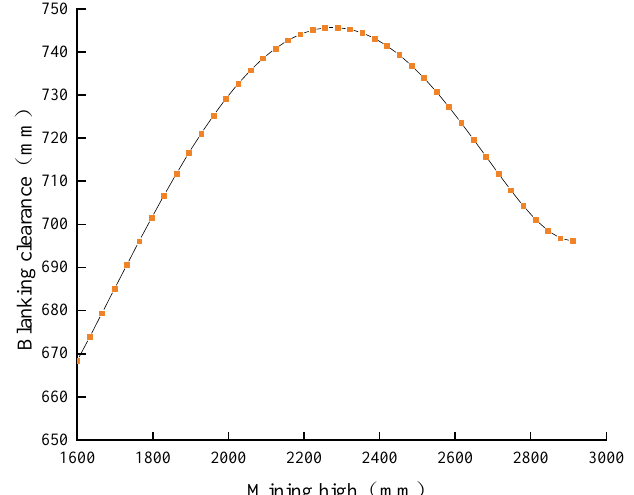
Figure 21. The change of blanking clearance of the ZC4800/16/30 backfilling hydraulic support. Based on the compaction force, compaction angle, distance from the top, and blanking clearance of the ZC4800/16/30 backfilling hydraulic support, its compaction characteristics meet the basic requirements.